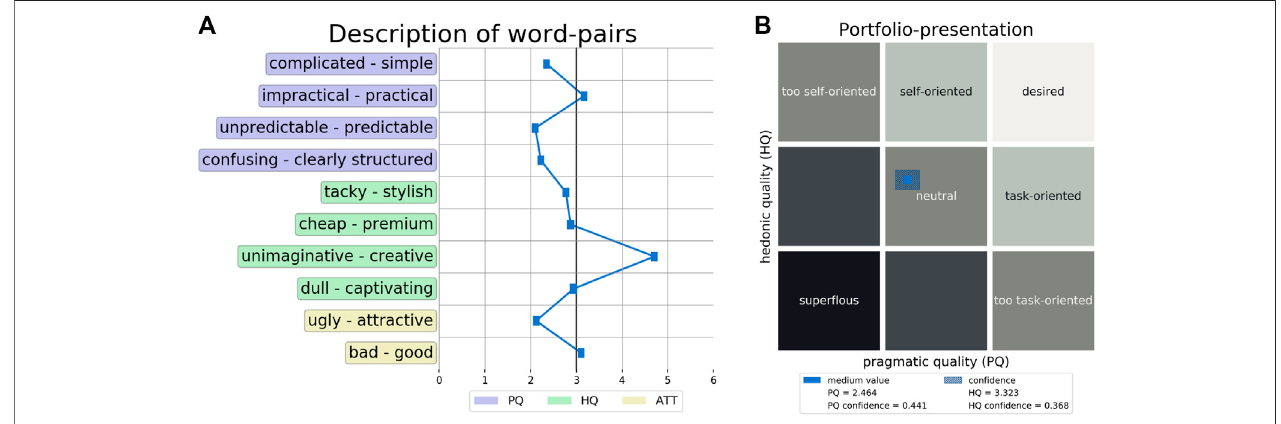
FIGURE 8 | Analysis of the outcomes from the AttrakDiff questionnaire (Hassenzahl et al., 2003) (A) : Description of word pairs. (B) : Portfolio presentation.